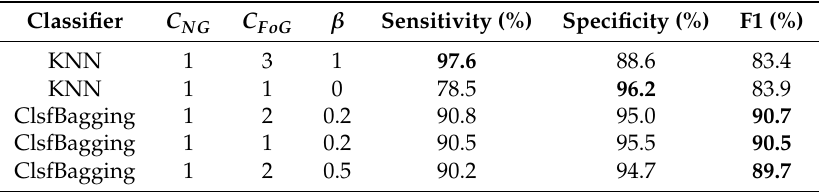
Table 4. Best performing classifiers in patient dependent models (Results show average performance of all seven participants). The bold values show the highest performance among all the classifiers.